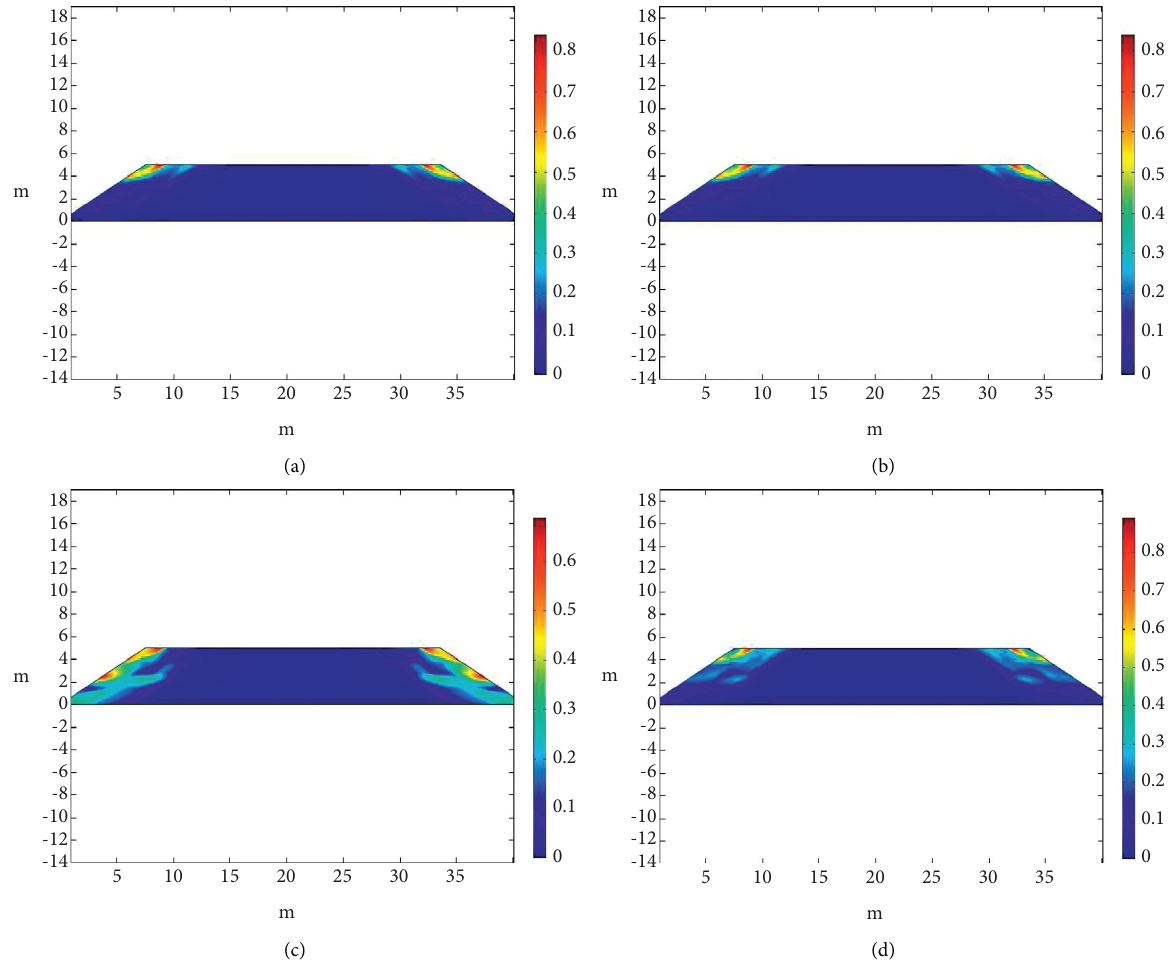
Figure 21: Efective plastic strain diagram of the cross-section of the reinforced Earth embankment at all times: (a) d � 1; (b) d � 3; (c) d � 5; (d) d �